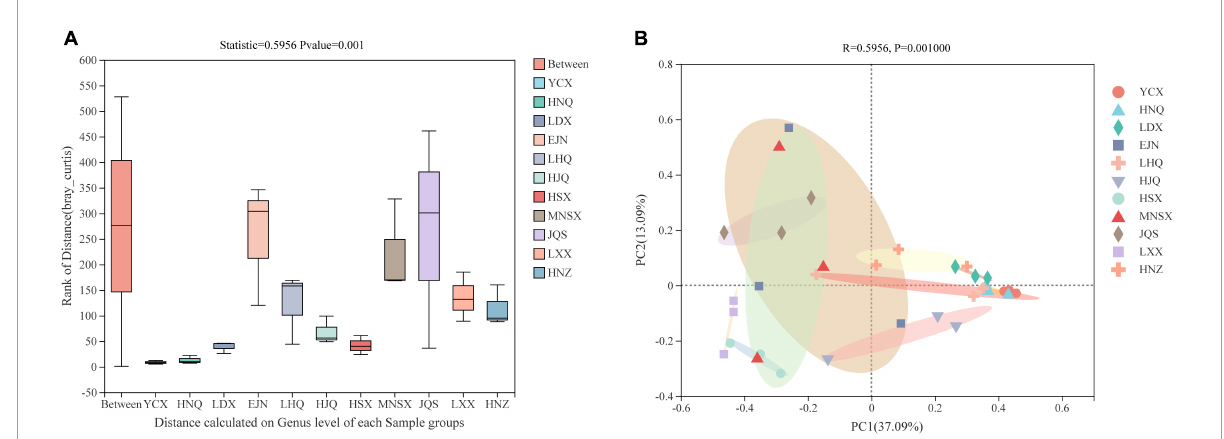
FIGURE2 Similarity ANOSIM analysis and PCoA analysis of endophytic fungal community in S. alopecuroides based on Bray-Curtis distance. (A) The X -axis is the distance value within or between groups, the box corresponding to “Between” represents the distance value of the difference between the groups, and the rest of the boxes represent the distance value of the difference within the group; the Y -axis scale represents the size of the distance value. (B) The X -axis and Y -axis represent the two selected main coordinate axes, and the percentage represents the interpretation value of the main coordinate axis for the difference in sample composition; The scales of the X -axis and Y -axis are relative distances and have no practical significance; Points with different colors or shapes represent different groups of samples, and the closer the two sample points are, the more similar the species composition of the two samples